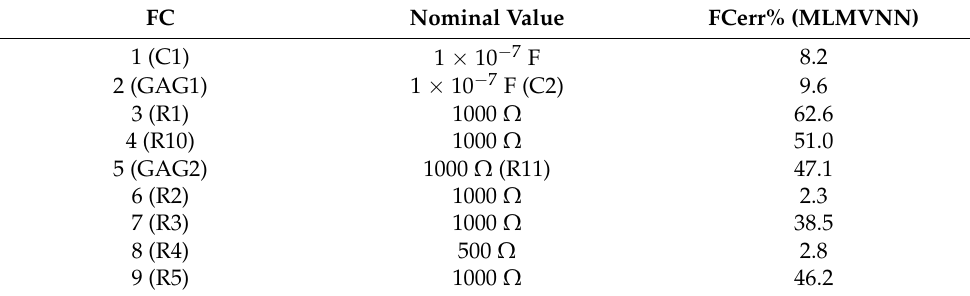
Table 4. Fault component identification